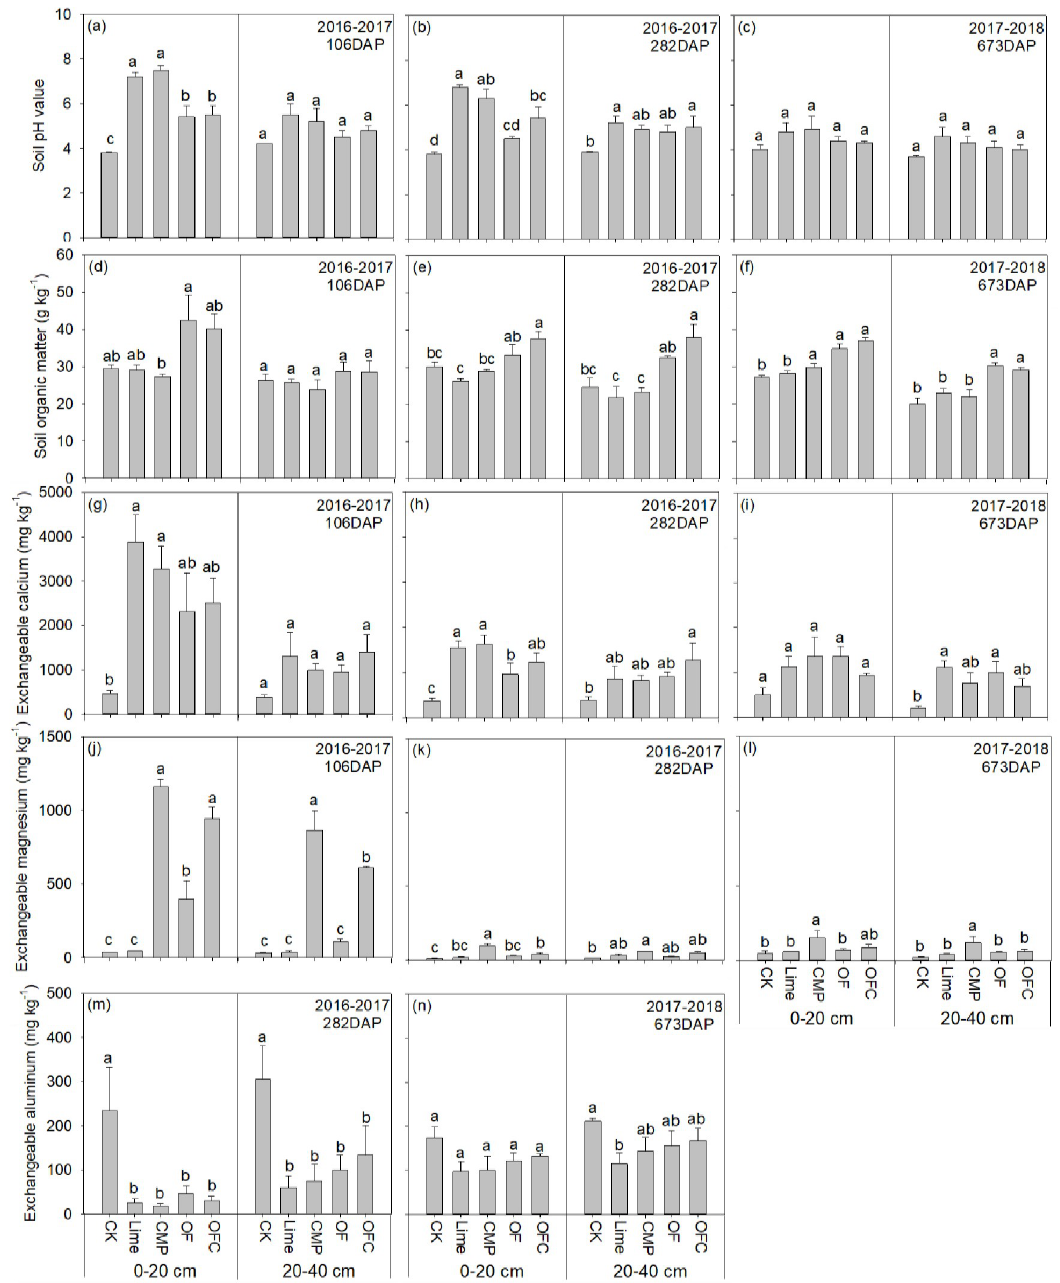
Fig 6. Effect of different soil amendments treatments on selected soil physico-chemical properties. The soil was amended with lime (Lime), calcium magnesium phosphate fertilizer (CMP), organic fertilizer (OF), organic fertilizer with calcium magnesium phosphate fertilizer (OFC) or remained unamended (CK). Values are means ± SE (n = 3). Different lowercase letters within each column denote significant differences among different treatments in 2016–2017 and 2017–2018 ( P < 0.05). SOM, soil organic matter.